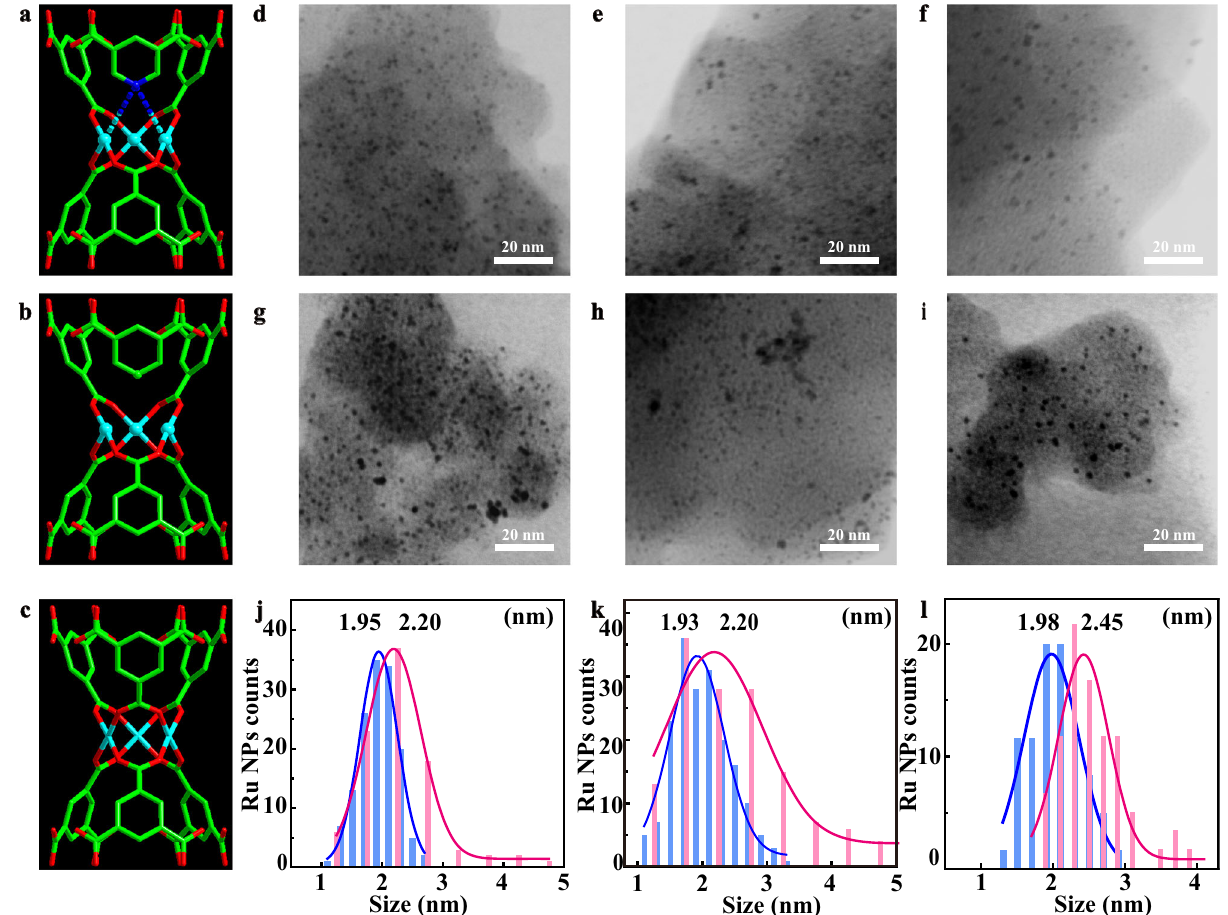
Fig. 2 Identi fi cation of Ru NPs in Ru-impregnated parent and defect-engineered MIL-100-Cr MOFs. a – c Schematic illustration of various Cr single active sites: MSAS with type-A defect in D 1a-c and Ru@D 1a-c , formed via incorporation of DL1 with a weak ligator N at defect sites ( a ); MSAS with type-B defect in D 2a-c and Ru@D 2a-c , generated by incorporation of DL2 without ligator at defect sites ( b ); pristine Cr single active sites ( c ). d – f STEM images of Ru@D 1a ( d ), Ru@D 2a ( e ), and Ru@D 0 ( f ) before catalyzing biomass hydrogenation of D-glucose to sorbitol. g – i STEM images of Ru@D 1a ( g ), Ru@D 2a ( h ), and Ru@D 0 ( i ), after catalyzing biomass hydrogenation of glucose to sorbitol for 12 runs. j – l Size distributions of Ru@D 1a ( j ), Ru@D 2a ( k ), and Ru@D 0 ( l ) before (blue) and after (pink) 12 runs of